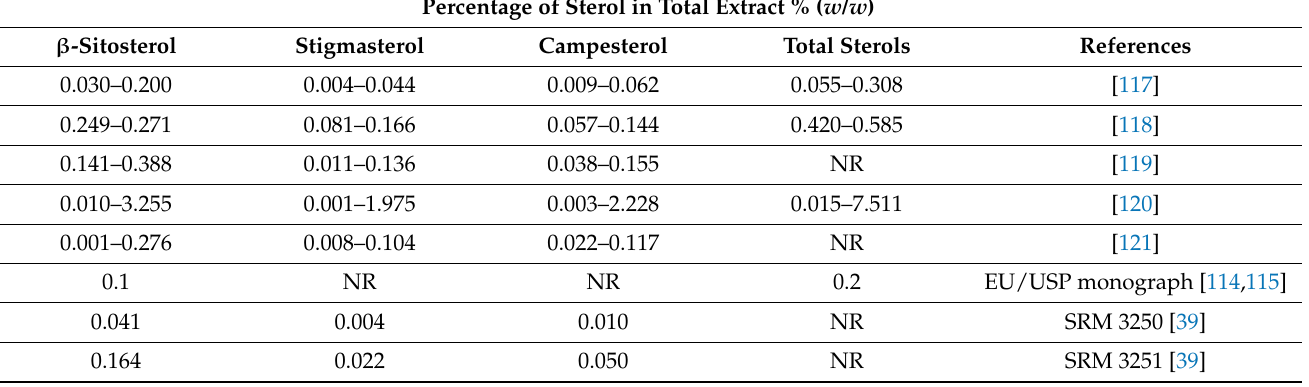
Table 3. Comparison of levels of phytosterols in dietary supplements between different studies.